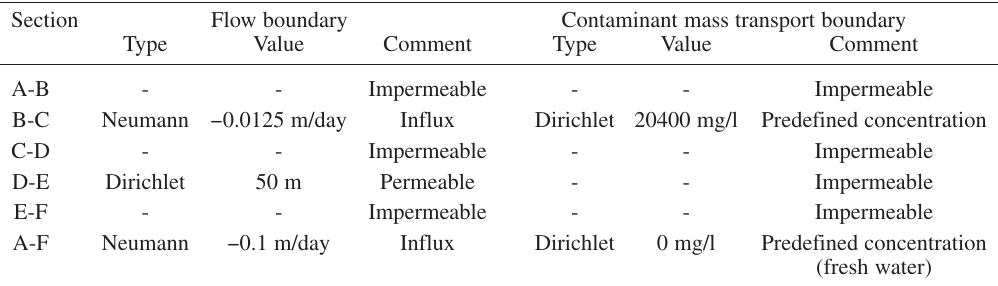
Table I. Flow and the mass transport boundary conditions. Section